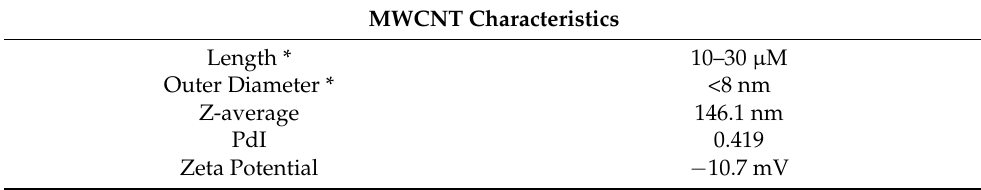
Table 1. MWCNT Physical